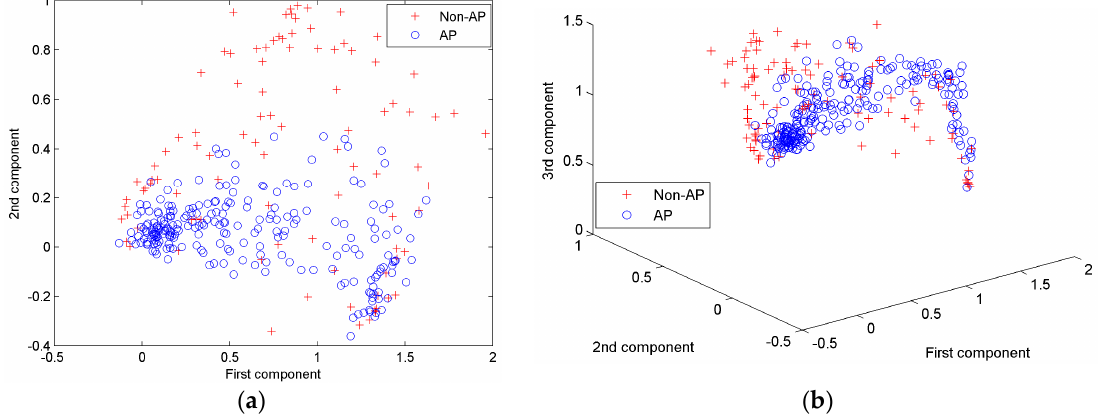
Figure 9. ( a ) First two principle components scatter plot; ( b ) First three principle components scatter plot. Table 7. Results of different components for SVM classification.